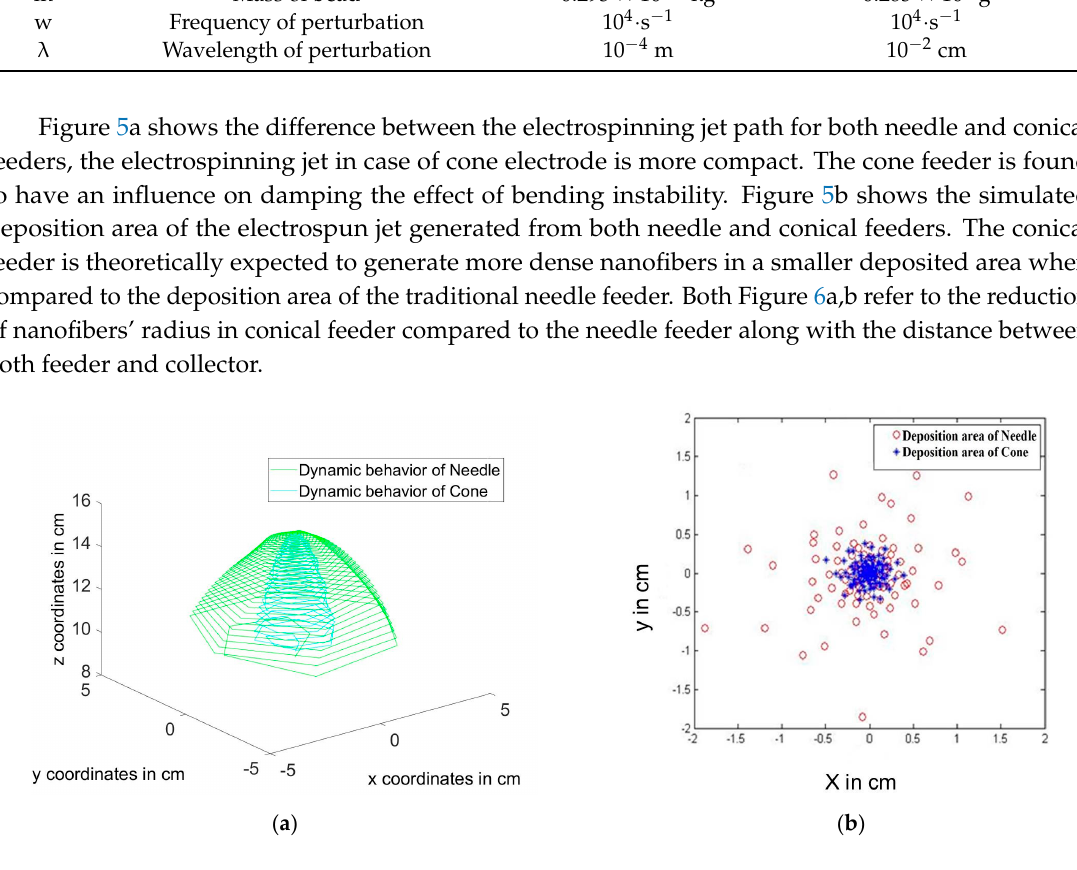
Figure 5. ( a ) Dynamic behavior analysis of the fibers jet of both cone and needle feeders and ( b ) Expected deposition area due to both feeders at specific z-value.